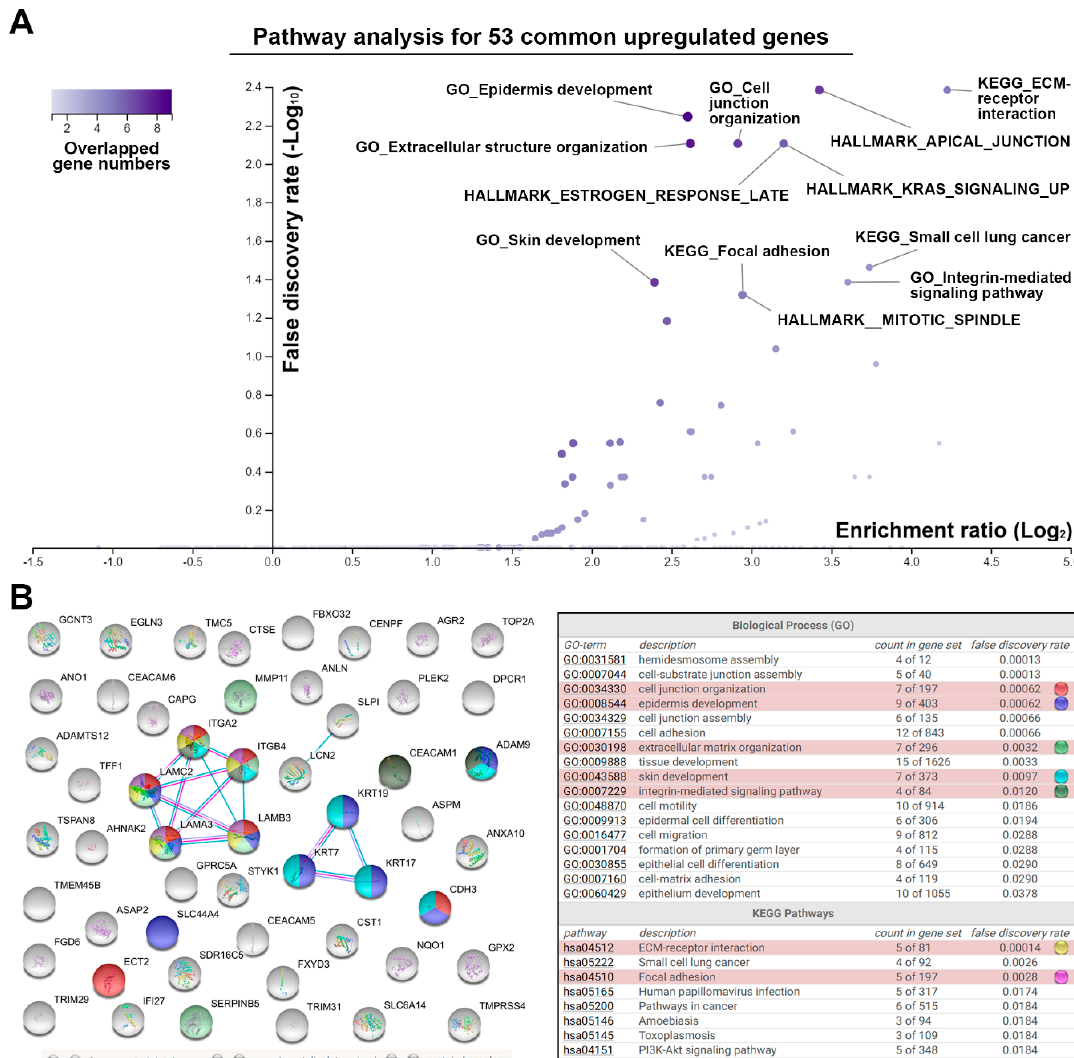
Figure 2. Pathway enrichment for the common upregulated genes in pancreatic ductal adenocarcinoma by the WebGestalt ( A ) and STRING database ( B ) web-based tools. Inset at top left in ( A ): a gradient color key shows the overlapped gene numbers in a pathway. In the volcano plot of ( A ), the purple circles for HALLMARK_ESTROGEN_RESPONSE_LATE / HALLMARK_KRAS_ SIGNALING_UP or KEGG_Focal adhesion / HALLMARK_MITOTIC_SPINDLE were overlapped. In the left part of ( B ), line colors indicate the types of interaction evidence. The cyan and pink lines indicate protein–protein interactions from curated and experimental data, respectively. The purple line indicates that two protein molecules share structural homology. Functional enrichment (gene ontology (GO) biological processes and Kyoto Encyclopedia of Genes and Genomes (KEGG) pathways) in this network are shown in the right part of ( B ). Selected GO biological processes and KEGG pathways are highlighted with di ff erent colors. The term “count in gene set” indicates the overlapped genes (the first number) in a pathway (the second number). The term “false discovery rate” indicates the average rate of false coverage for the functional enrichment.